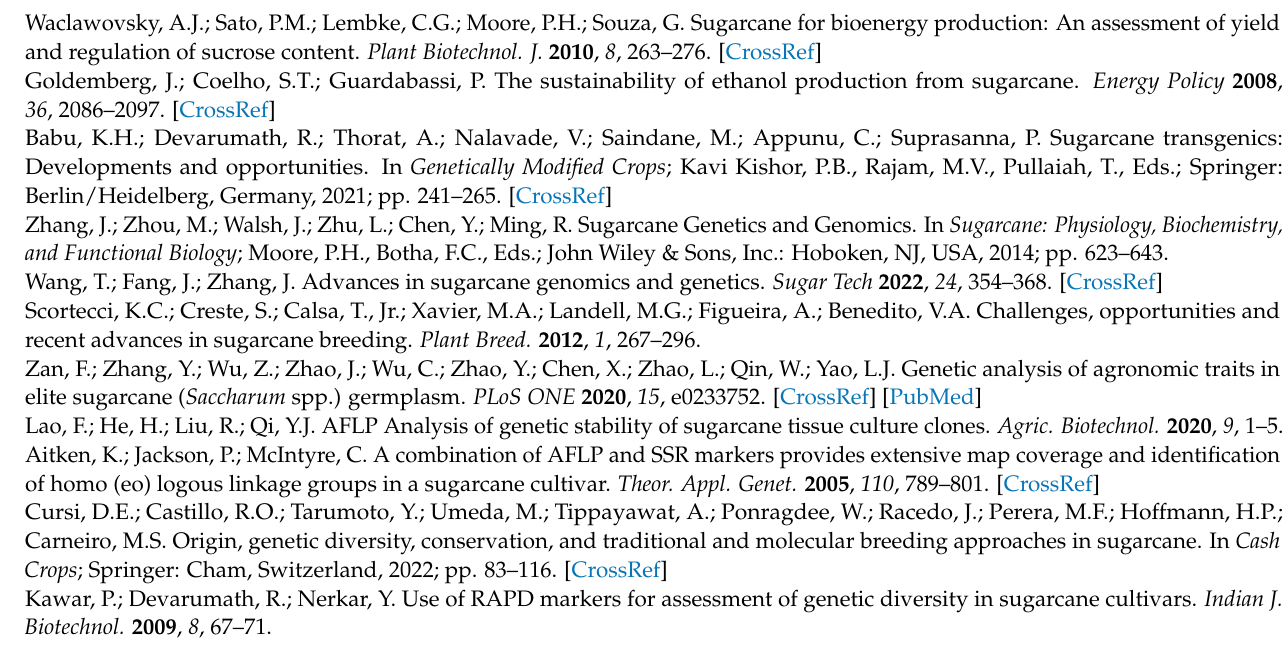
species. Figure S2: Phylogenetic trees for six Saccharum species based on species-specific or species- associated SSR alleles. Table S1: The information of 196 sugarcane accessions of Saccharum spp. hybrids and six related Saccharum species. Table S2: Chi-square test, the percentage good-to-fit testing, single-marker test, and t -test of 24 species-specific or species-associated SSR alleles among 196 Saccharum